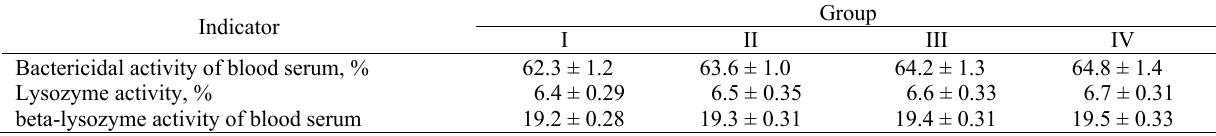
Natural resistance of experimental animals Indicator